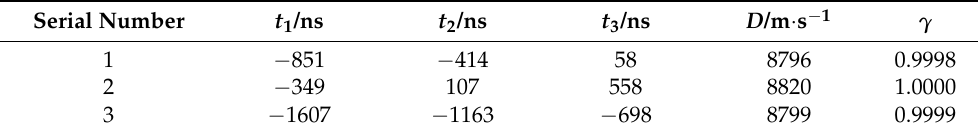
Table 8. Experimental data with L = 4 mm, a = 0.5 mm.